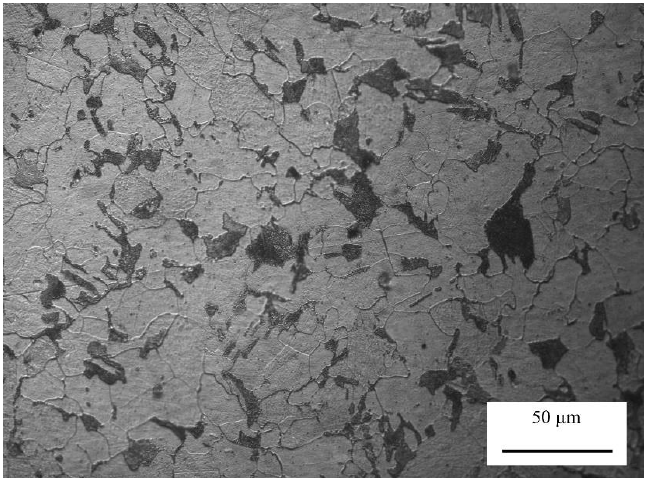
Figure 6. Ferrite – pearlite microstructure of the investigated steel. Figure 6. Ferrite–pearlite microstructure of the investigated